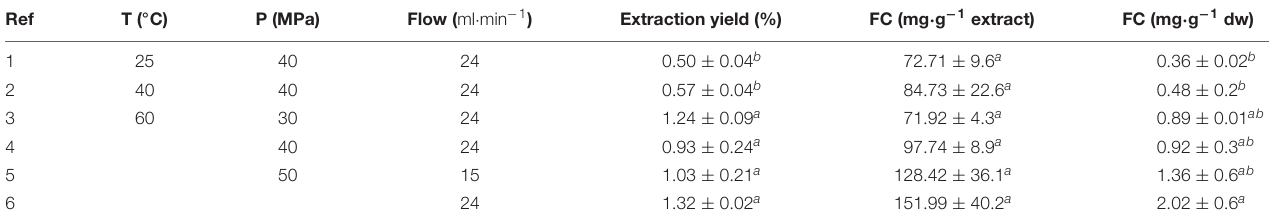
FIGURE 4 | Principal component analysis of fucoxanthin content, total phenolic content, and yield of extraction of algae (dry weight). TABLE 3 | Extraction yield and fucoxanthin recovery of Dictyopteris polypodioides ScCO 2